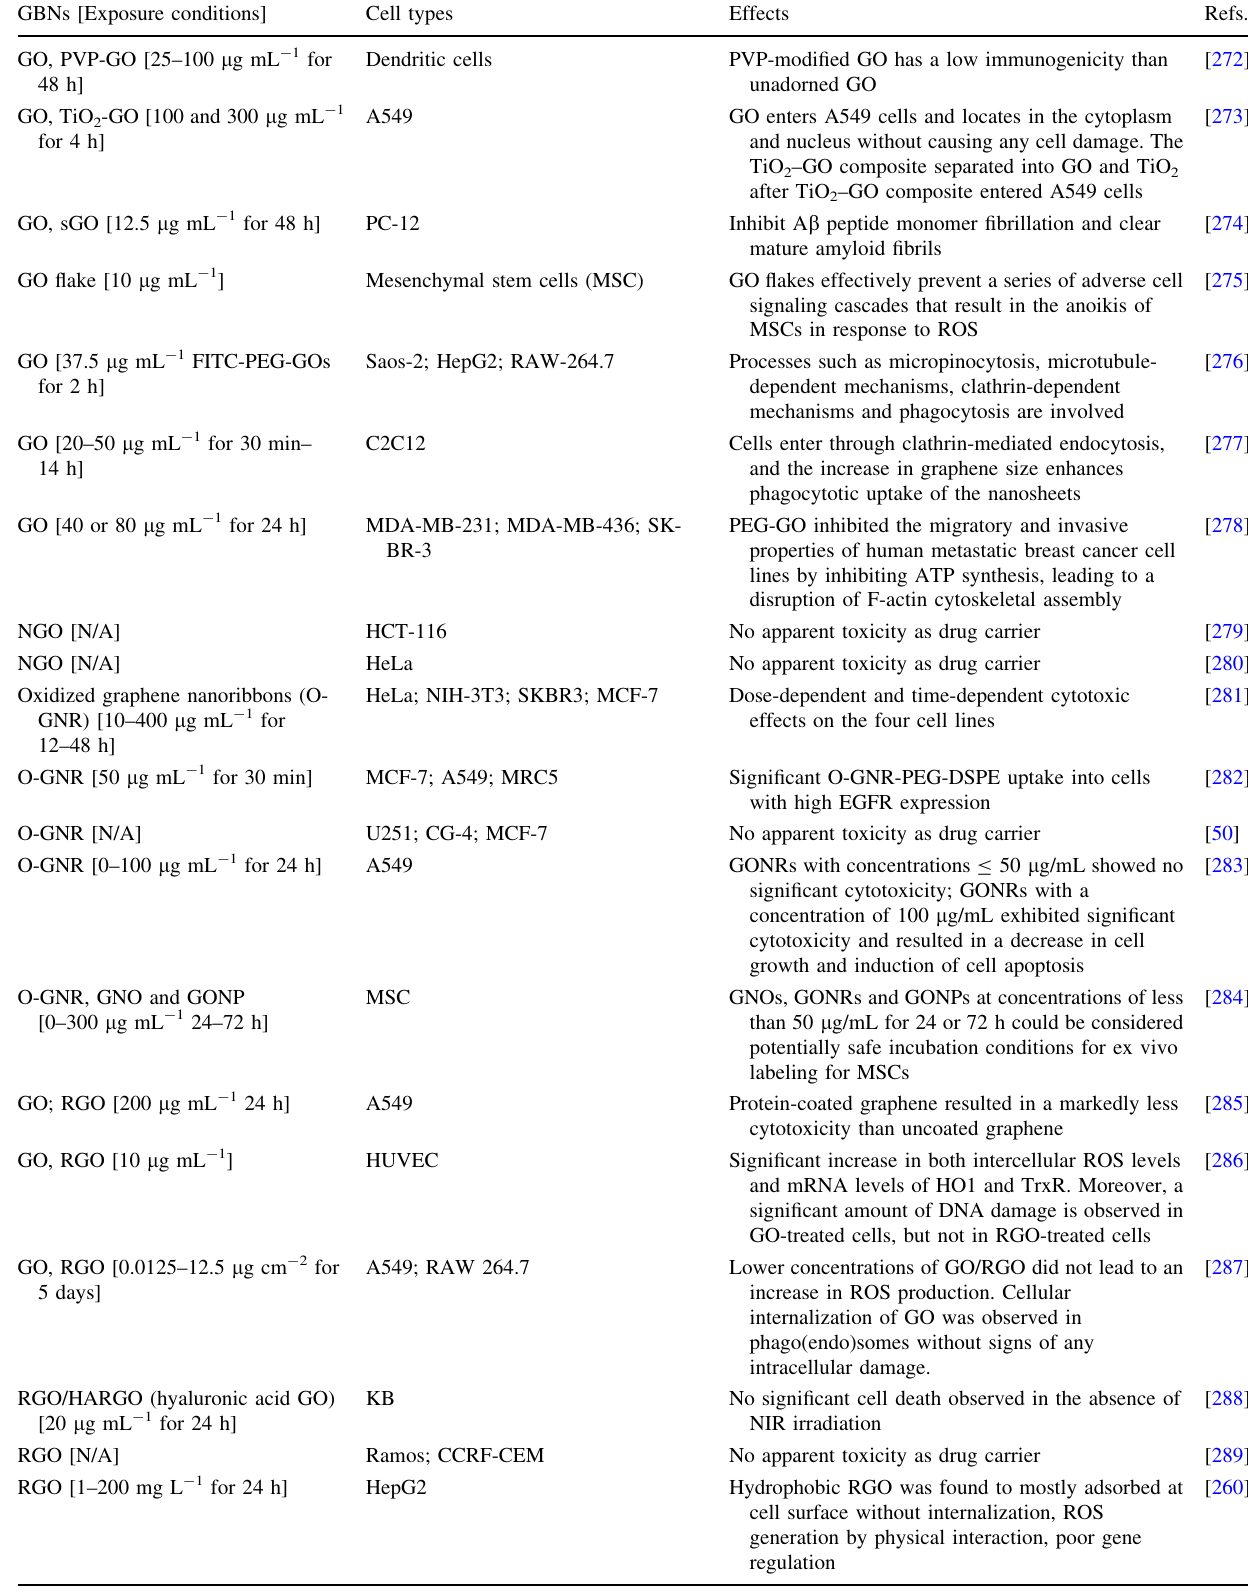
Lower concentrations of GO/RGO did not lead to an increase in ROS production. Cellular internalization of GO was observed in phago(endo)somes without signs of any intracellular